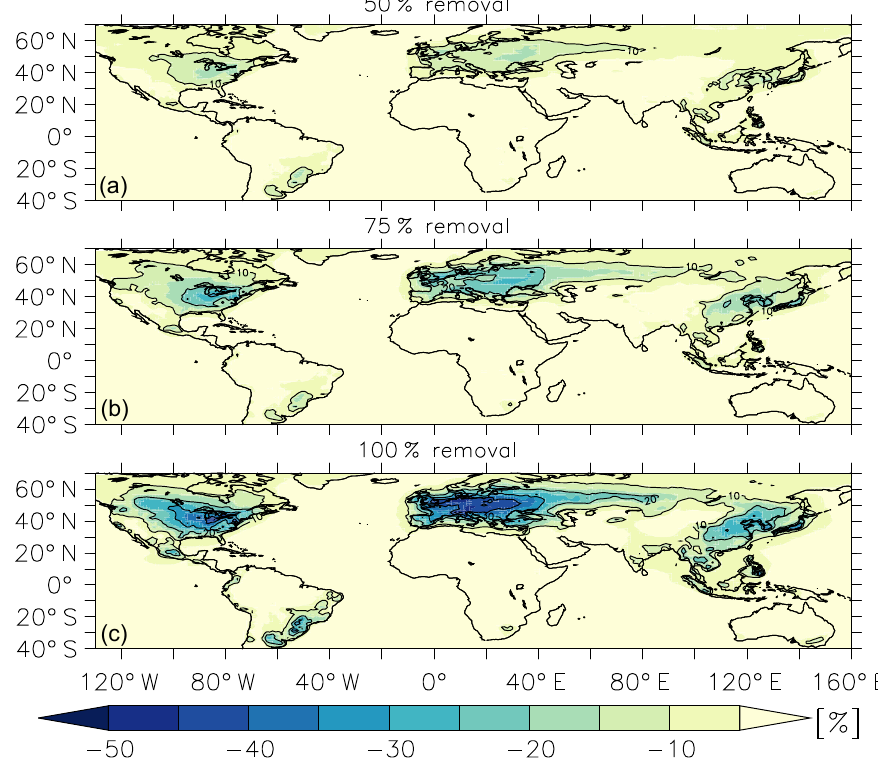
Figure 5. Relative annual average surface PM 2 . 5 concentration changes (in %) from the three scenarios with agricultural emissions reductions of 50, 75 and 100% ( a , b and c ,